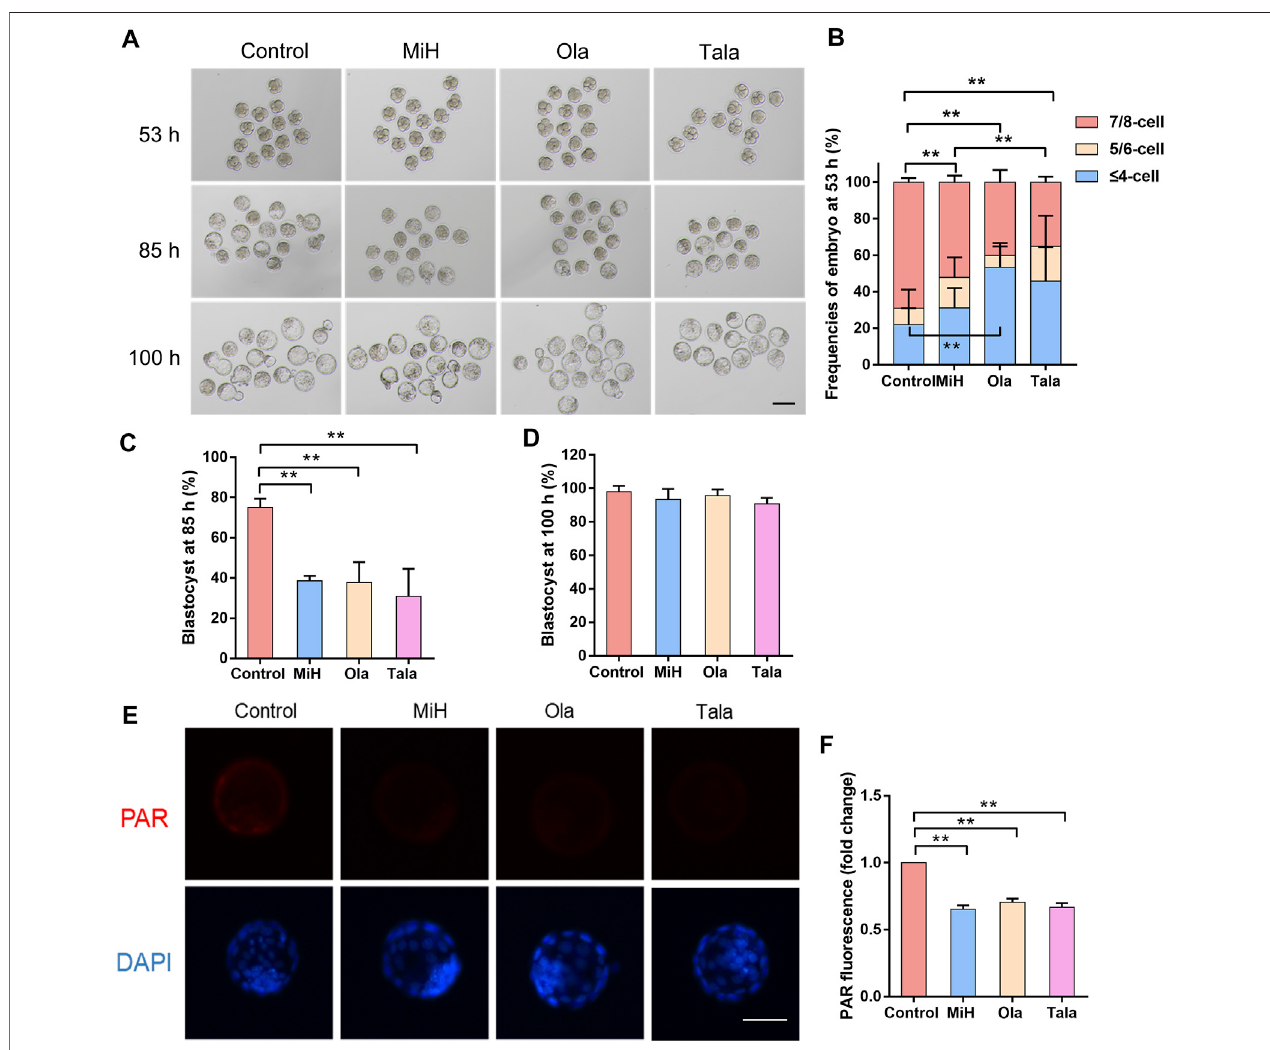
FIGURE2| CanonicalPARP1 inhibitors showedsimilar effects onpreimplantation embryos. (A) Bright fi eldimagesofembryos incontrol,MiH-,Olaparib (Ola)-and Talazoparib (Tala)-treated groups at 53, 85 and 100 h after fertilization. Bar (cid:1) 100 μ m. (B – D) Frequencies of embryos observed at 53 h (B) and blastocyst formation ef fi ciencies at 85 h (C) and 100 h (D) . n (Control) (cid:1) 46, n (MiH) (cid:1) 44, n (Ola) (cid:1) 45, n (Tala) (cid:1) 43. (E,F) Staining and fl uorescence intensity of expanded blastocysts in the four groups for PAR. Bar (cid:1) 50 μ m. Data are presented as mean ± SD in three independent experiments and student ’ s t tests are used for statistical analysis. p , 0.01 < p < 0.05; pp , p < 0.01; no labeling indicates no statistical signi fi cance.